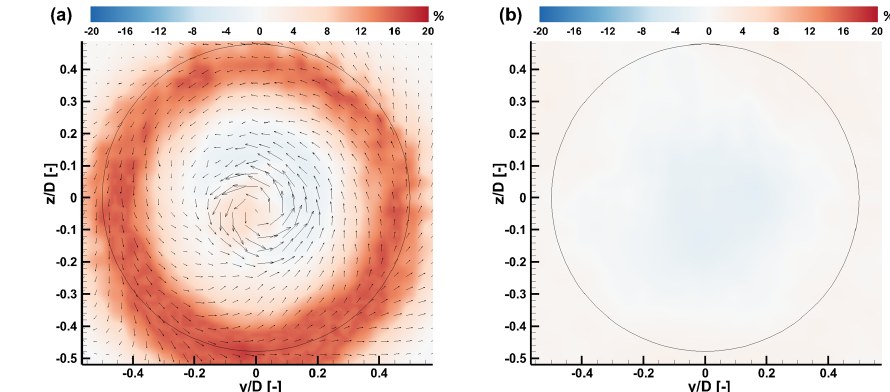
Figure 16. Percent streamwise velocity difference in the wakes of the G06 and of the DTU 10MW at x/D = 1 (a) and at x/D = 5 (b) . Arrows indicate the difference between in-plane velocities. The black circle denotes the rotor